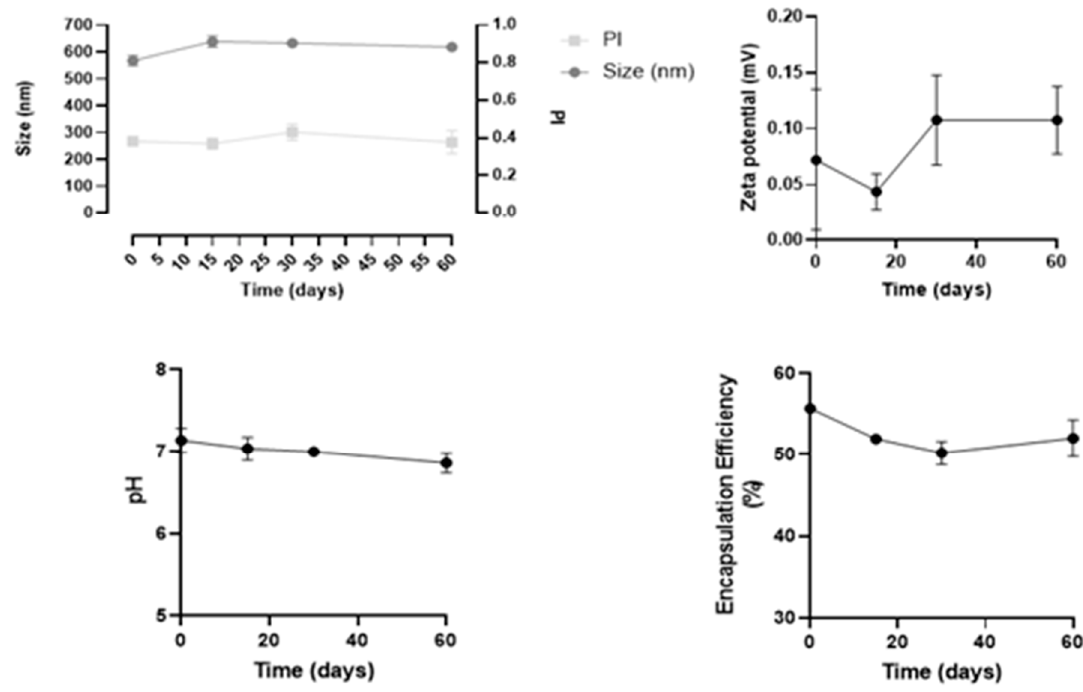
Figure 4. Results of stability studies of insulin-loaded NPs over 60 days. All data are presented as mean ± SD (n = 3).